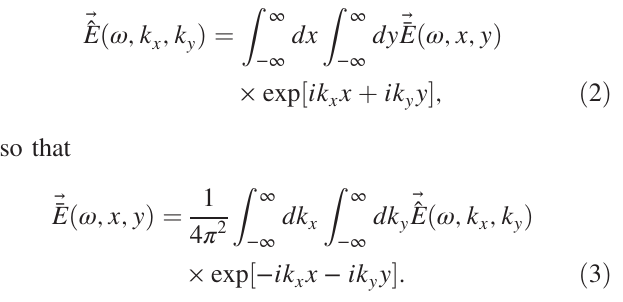
FIG. 2. Simulation of a radiation transport through the mono- chromator is an essential part of start-to-end simulations of the SXRSS setup performance.